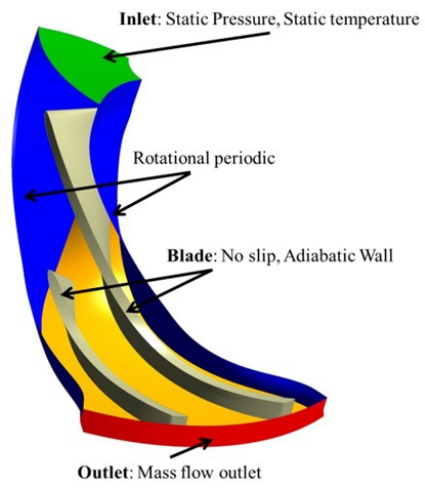
Figure 4. Boundary conditions used for the computational model of impeller alone